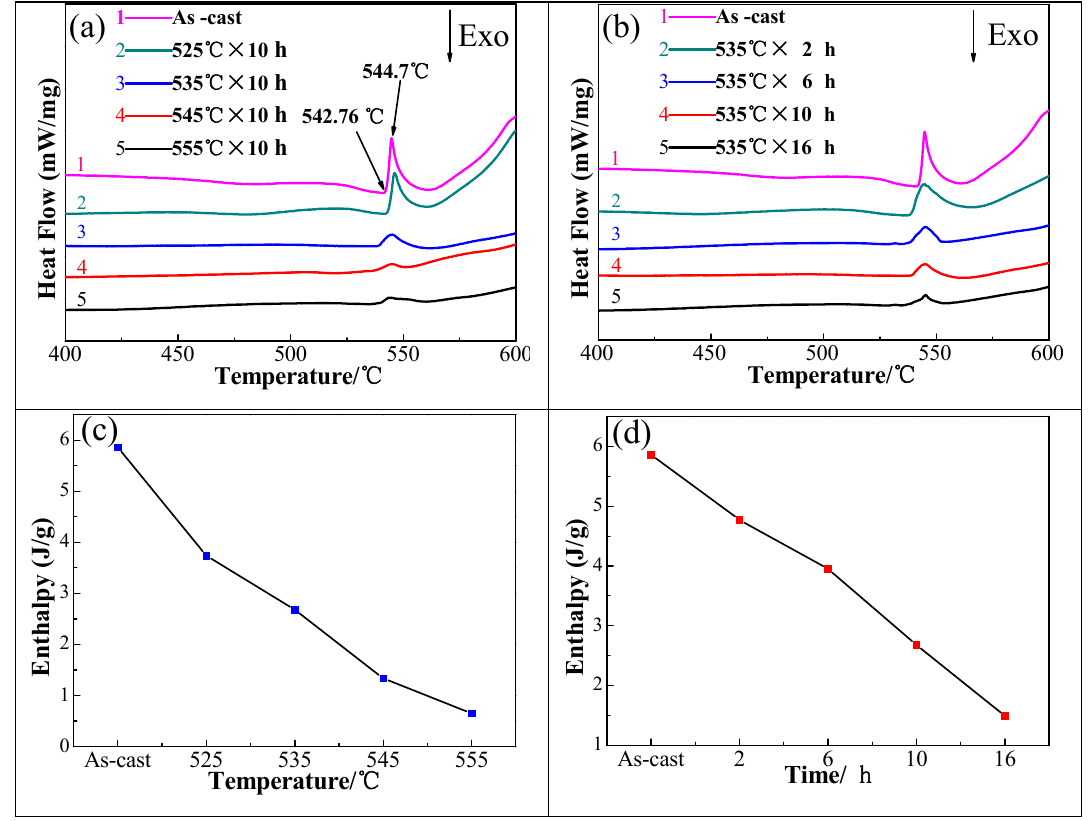
Figure 7. Differential scanning calorimetry (DSC) results of as-cast and homogenized alloy: ( a ) DSC curves of as-cast ingot and specimens homogenized for 10 h at different temperature; ( b ) DSC curves of as-cast ingot and specimens homogenized at 535 °C for different time; ( c ) Temperature and enthalpy values corresponding to ( a ); ( d ) Time and enthalpy values corresponding to ( b ).